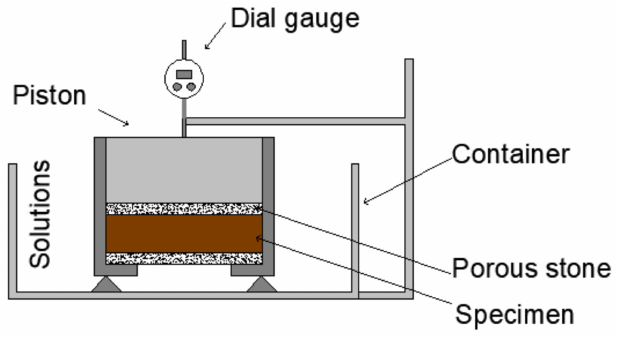
Figure 2. Unloaded swelling strain test